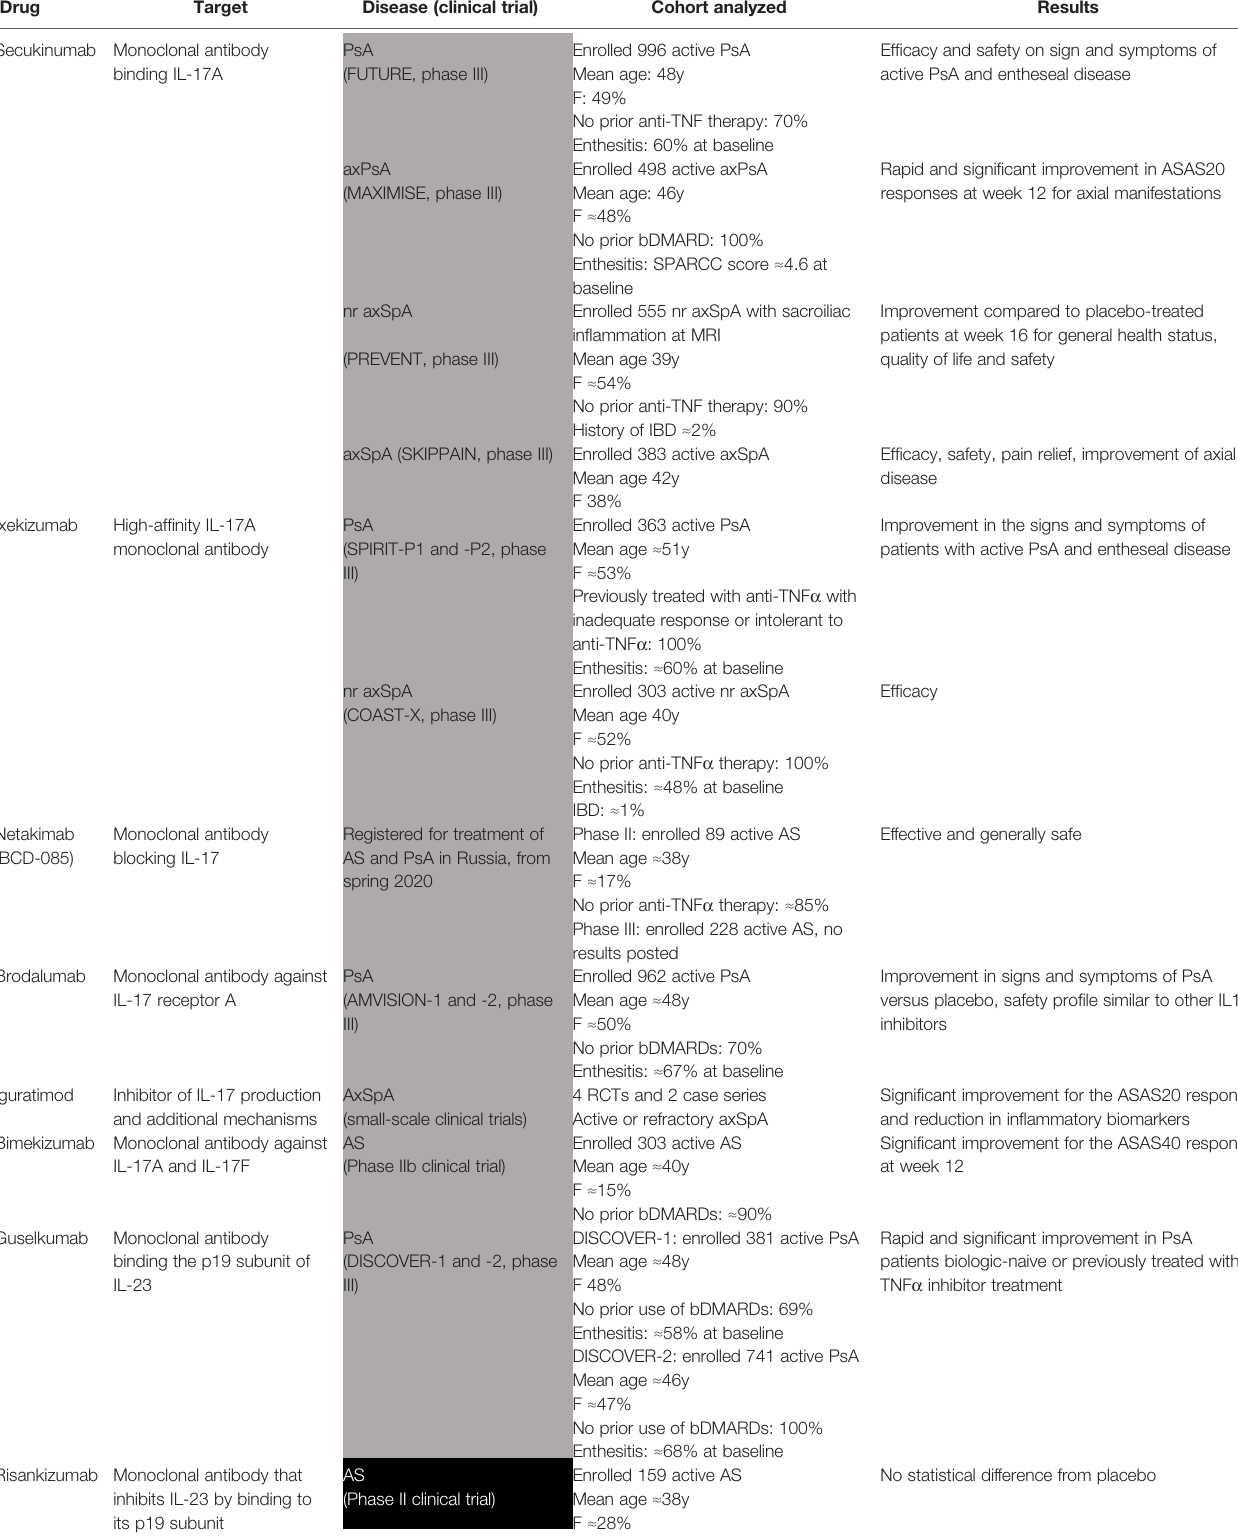
TABLE 1 | Molecules blocking the IL-17/IL-23 axis, studied for the treatment of